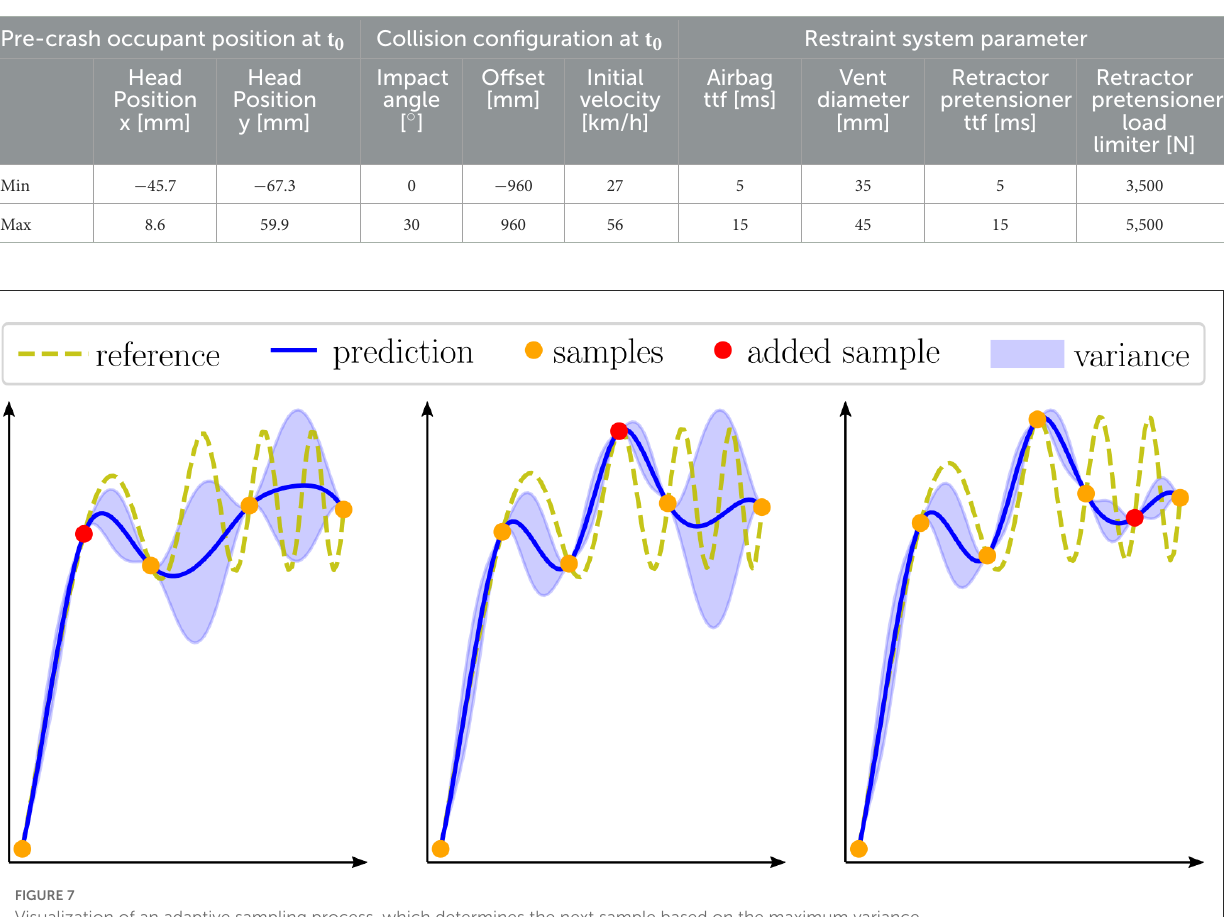
TABLE 1 Considered input parameter ranges for human body model response prediction.